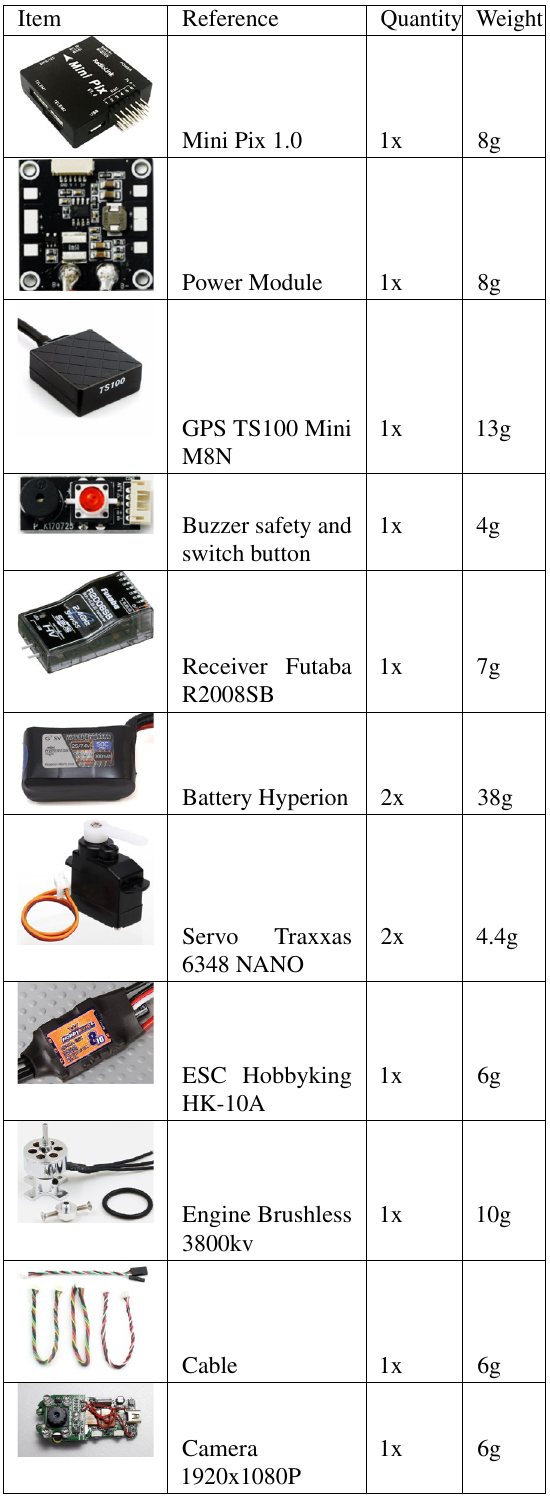
Table 2. Electric and electronic components used in the development of the MicroBrosh UAV final